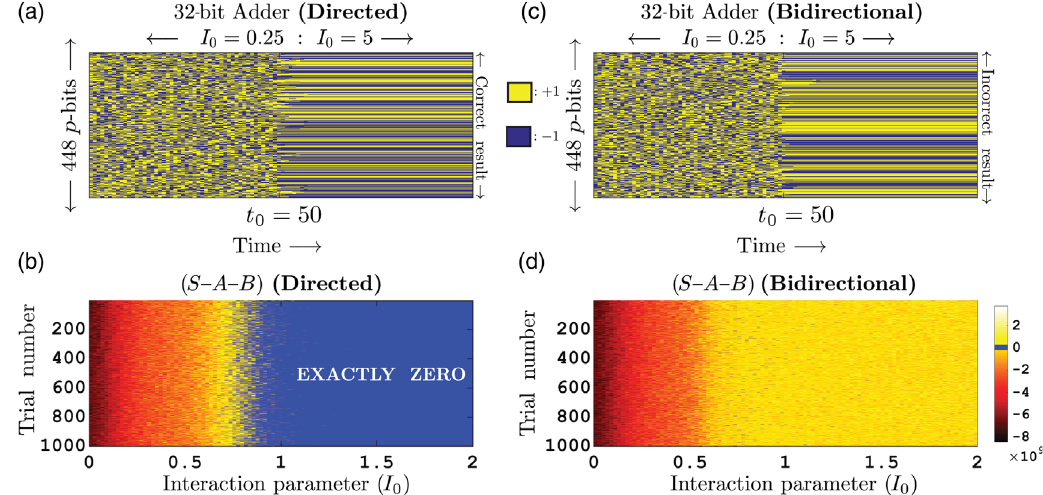
FIG. 13. Accuracy of 32-bit adder, directed versus bidirectional. The results are shown for the adder operating in a subtractor mode, S ), and observing the other 32-bit input B , which should clamping one (random) 32-bit input ( A ) and a (random) 33-bit output ( C out þ provide the difference S – A . (a) Color map of the binary state of each of the 448 p -bits comprising the directed adder as a function of time with the interaction parameter I 0 suddenly increased from 0.25 to 5 at t 0 ¼ 50 . For low values of I 0 at t < 50 , the collection of p -bits is like a molten liquid which is quenched at t 0 ¼ 50 into a solid. (b) Surprisingly, this solid corresponds to a “ perfect crystal ” in each of the 1000 trial experiments, with S – A – B exactly equal to zero (dark blue). (c) Same as (a) but for a bidirectional adder. Here, too, the “ liquid ” quenches to a solid at t 0 ¼ 50 , but in this case the resulting “ solid ” is full of defects (with hardly any zeros), with S – A – B ≠ 0 , yielding a different wrong result for each trial as evident from (d). For (c) and (d) the color bar is modified to have a dark blue color corresponding to exactly zero. S , A , B are taken to be the statistical mode of the 100 × 1 array obtained at the end of each